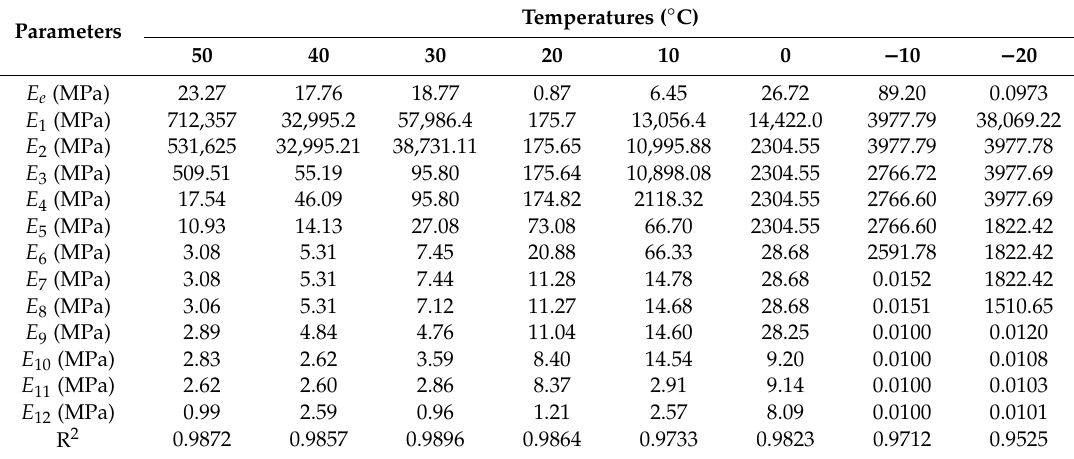
Table 10. The fitting parameters of DBFAM based on the generalized Maxwell model.